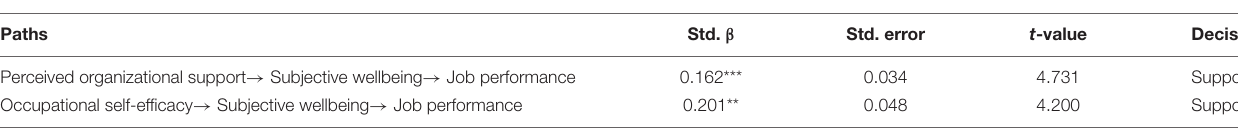
FIGURE 2 | Results of structural model. *** of p < 0.001. TABLE 4 | Indirect effect of structural model. Paths Std. β Std.